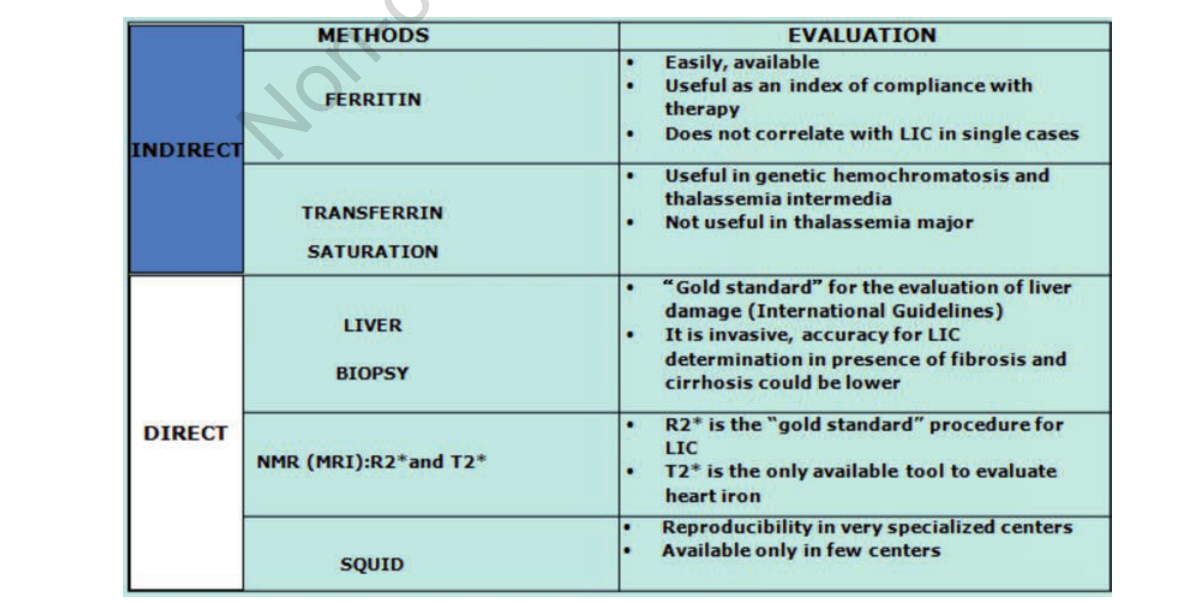
Figure 5. Direct and indirect methods to detect iron overload in patients affected by secondary